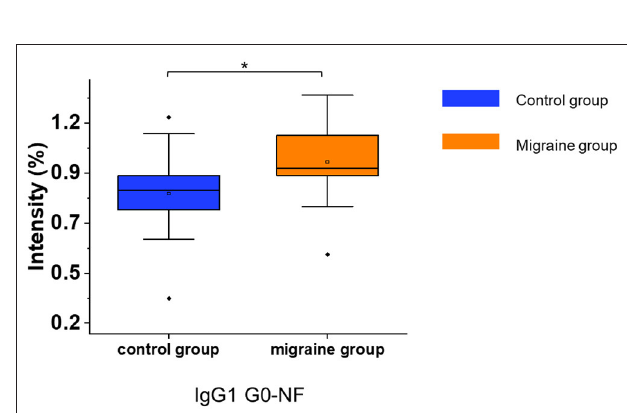
Where, X = [ x 1 , x 2 , . . . , x n ] represents the n input features,